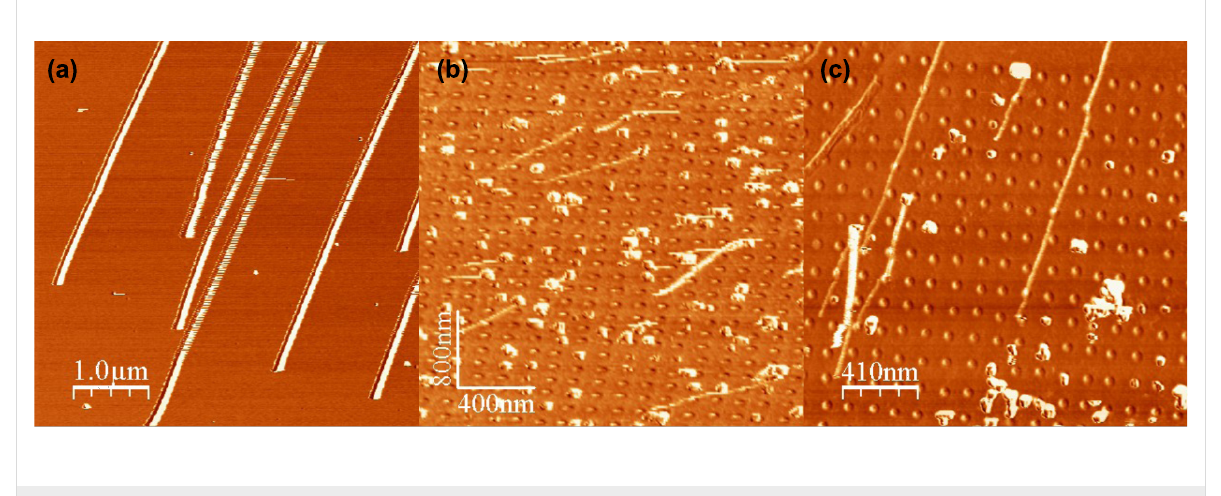
Figure 9: Manipulation of as-synthesized Au nanoparticles on (a) a flat silicon wafer with a spacing of 9.7 nm and (b) a nanopatterned one with a spacing 16 nm, and (c) a patterned wafer with a spacing of 3.9